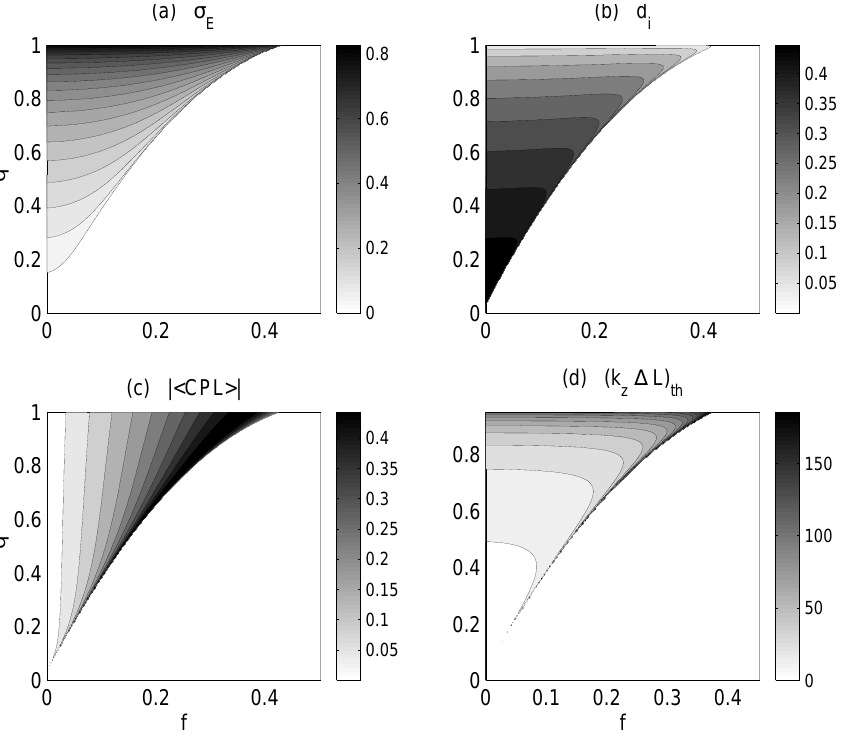
Fig. 4. Contours of constant levels in the (q,f ) regions compatible with the appearance of the ion sense of po- larization in the field interference pat- tern of two plane whistlers, for different parameters characteristic of the waves’ polarization: (a) electric field ratio σ E | (see Eq. 41); (b) relative = | E 2 /E 1 plasma volume d i (see Eq. 45) filled by ion-type polarized electric fields; (c) absolute value of the circular polariza- tion level |h CPL i| averaged over the regions containing ion-type polarized fields (see Eq. 49); (d) minimum thresh- old ( k z 1 L) th of the phase k z 1 L (see Eq. 51), where k z is the parallel wave number of the waves and 1 L the cross section of the whistler ray beam along the ambient magnetic field. In all pic- tures, the actual values of the param- eters σ E , d i , |h CPL i| and ( k z 1 L) th have been set to zero for (q, f ) val- ues where no ion-type field polarization was